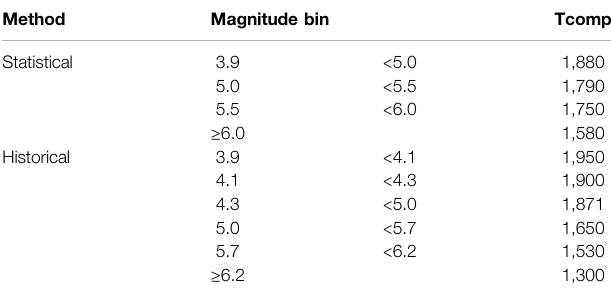
TABLE 1 | Completeness periods from Meletti et al. (2019), based on historical andstatisticalmethods,consideredherewithequalweights(Tcomp (cid:1) starting date of the completeness period; end date